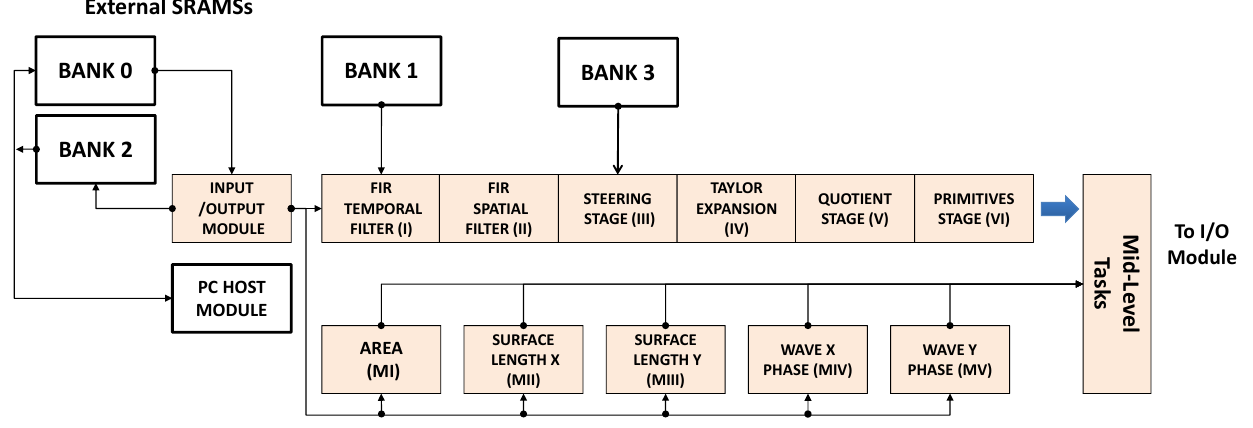
Figure 1. Scheme of the VLSI architecture of the Multi-Modal Sensor implemented in the